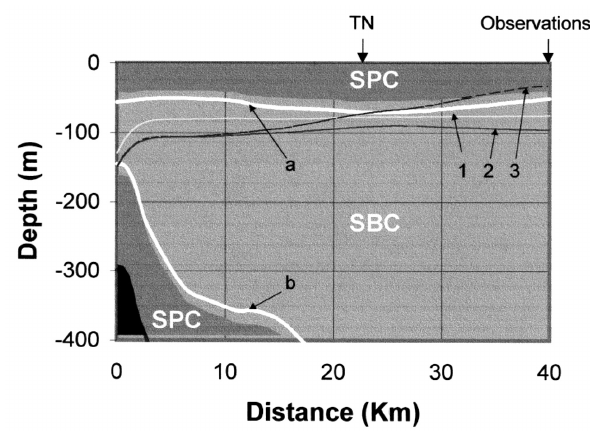
F IG . 3. – Diagram showing the mathematically permitted regions of supercritical (SPC, dark shadowed areas) and subcritical (SBC, light shadowed area) flows for the values mentioned in the text. Black area is the bottom sea. Thick line labelled a (b) is the new (|Q |) boundary of the upper (lower) SPC region in the case that Q 1 2 increases. White line labelled “1” would represent the interface depth for a submaximal exchange in which no control sections exist. Grey line labelled “2” is for a submaximal situation with control at the sill in the case that the lower SPC area is bound by line “b”. Grey line labelled “3” is for a maximal situation in the case that the SPC and SBC regions are bound by lines “b” (lower) and “a” (upper) respectively. TN indicates the position of Tarifa Narrows. The eastern section in which observations were made is also